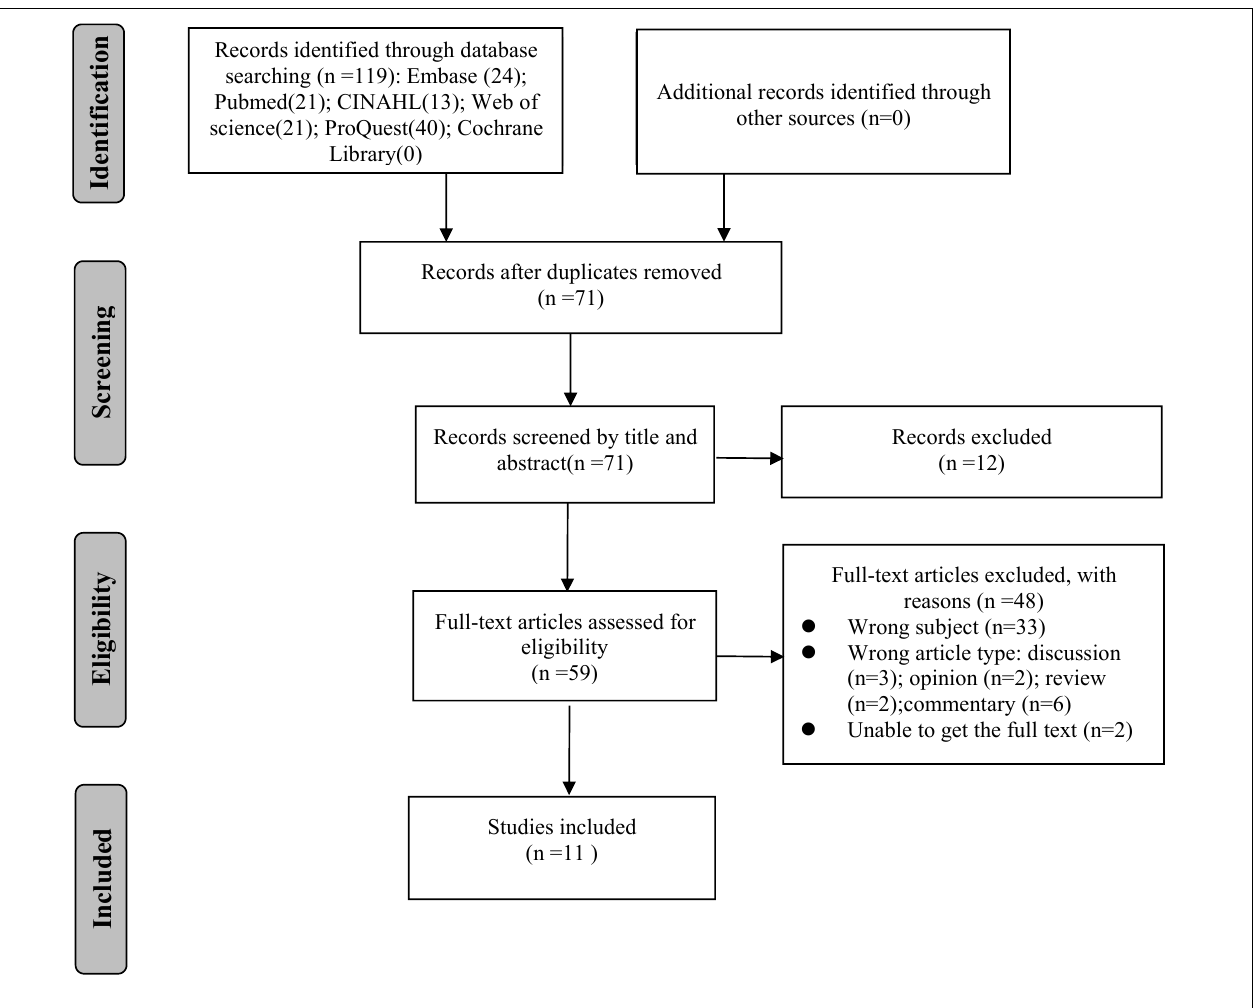
FIGURE 1 | Literature screening